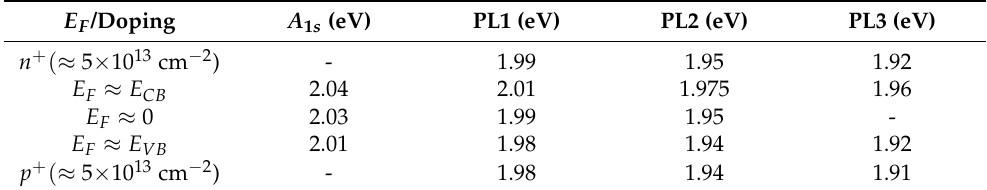
Table 1. Energies of exciton species found in PL and SIE measurements for selected doping concen- trations and positions of the Fermi-energy E F . The uncertainty in the determination of the energies is in the order of 10 meV.